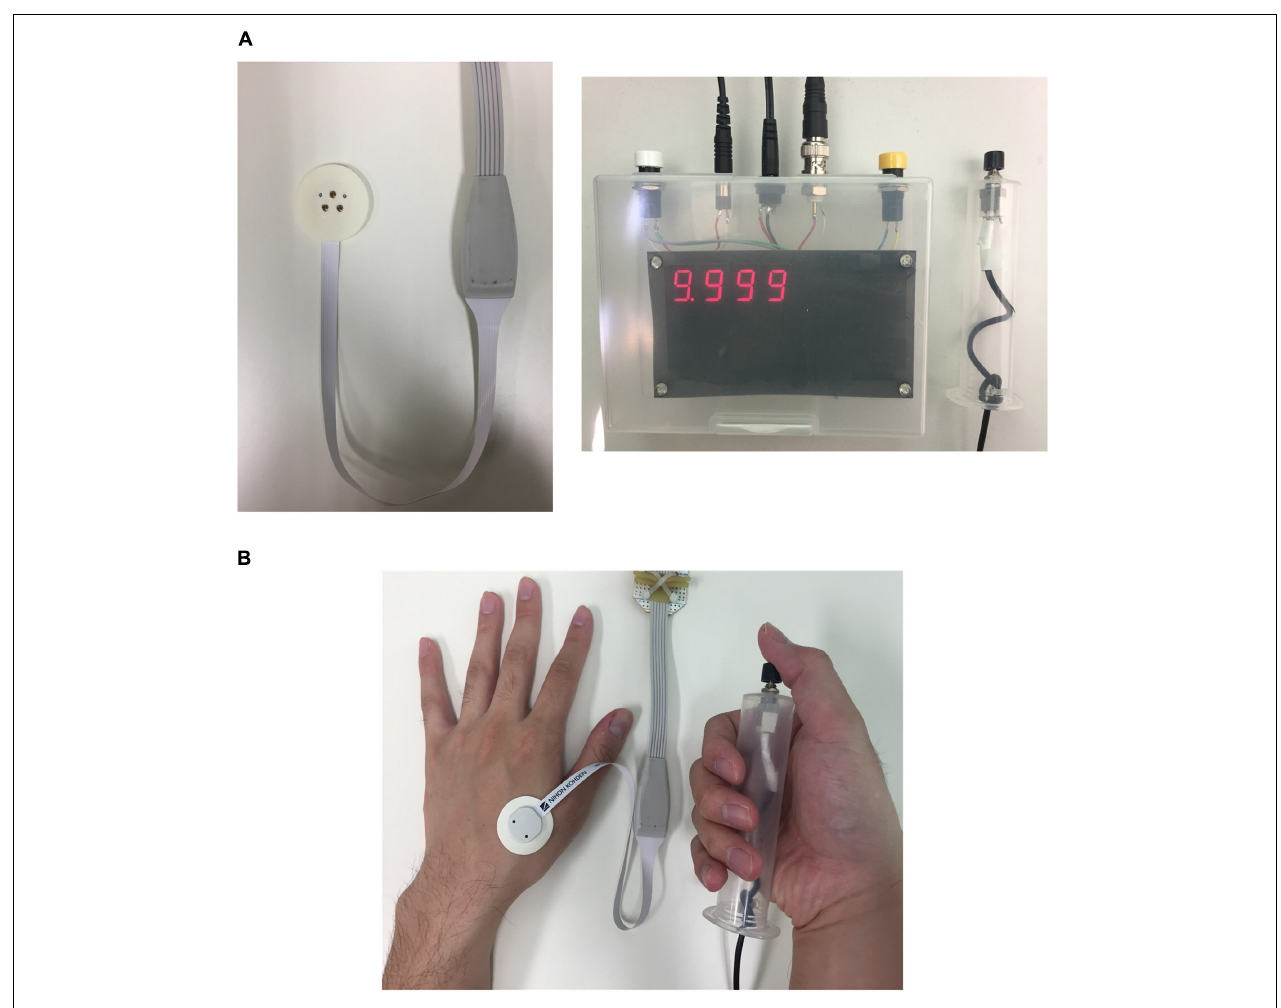
FIGURE 1 | Experimental setup: (A) concentric bipolar electrode needle and measurement equipment of reaction time (time between stimulation and detection of sensation) and (B) photo of a participant pressing the push-button during perception threshold detection